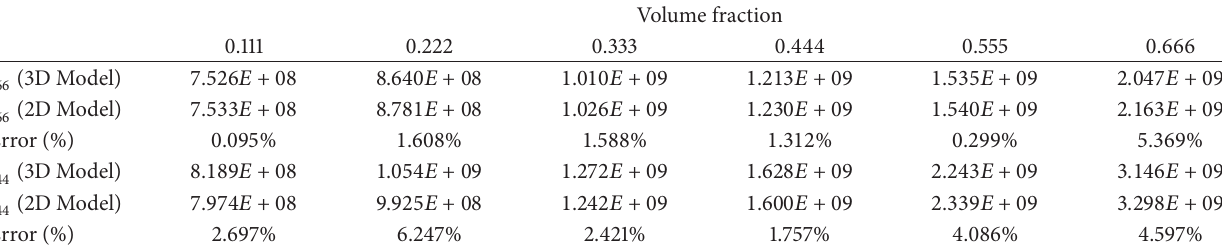
Figure 15: (a) Turner triangle geometry and (b) displacement interpolation. Table 3: Comparison of the results calculated by 2D and 3D